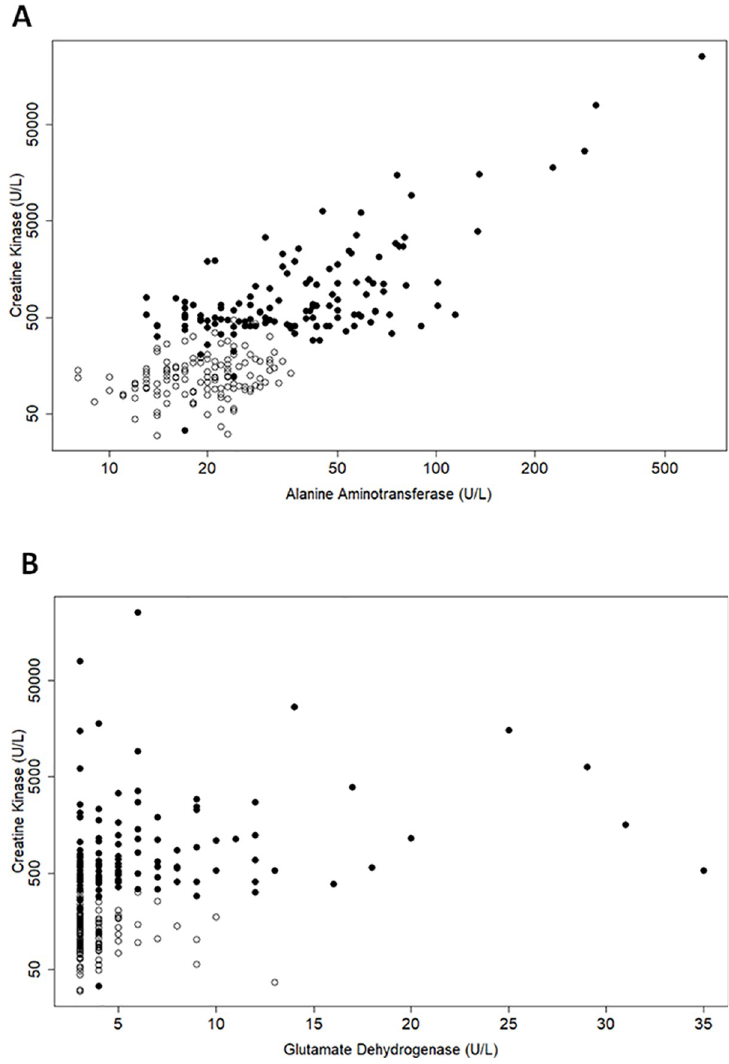
Fig 1. GLDH levels are not affected by acute muscle diseases. A is a comparison of CK and ALT; B is a comparison of CK and GLDH. Each point represents CK, ALT or GLDH values from an individual serum sample collected from a total of 125 healthy subjects (open circles) and 131 subjects with a variety of muscle impairments (closed circles).